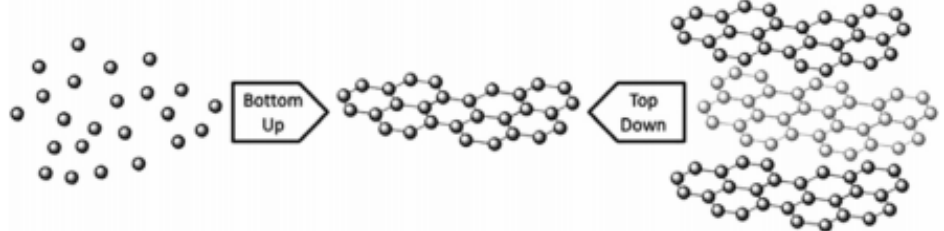
Figure 4. Top-down model and bottom-up synthesis of graphene. “Reproduced with permission from [19], [Materialia]; published by Elsevier, 2020”.